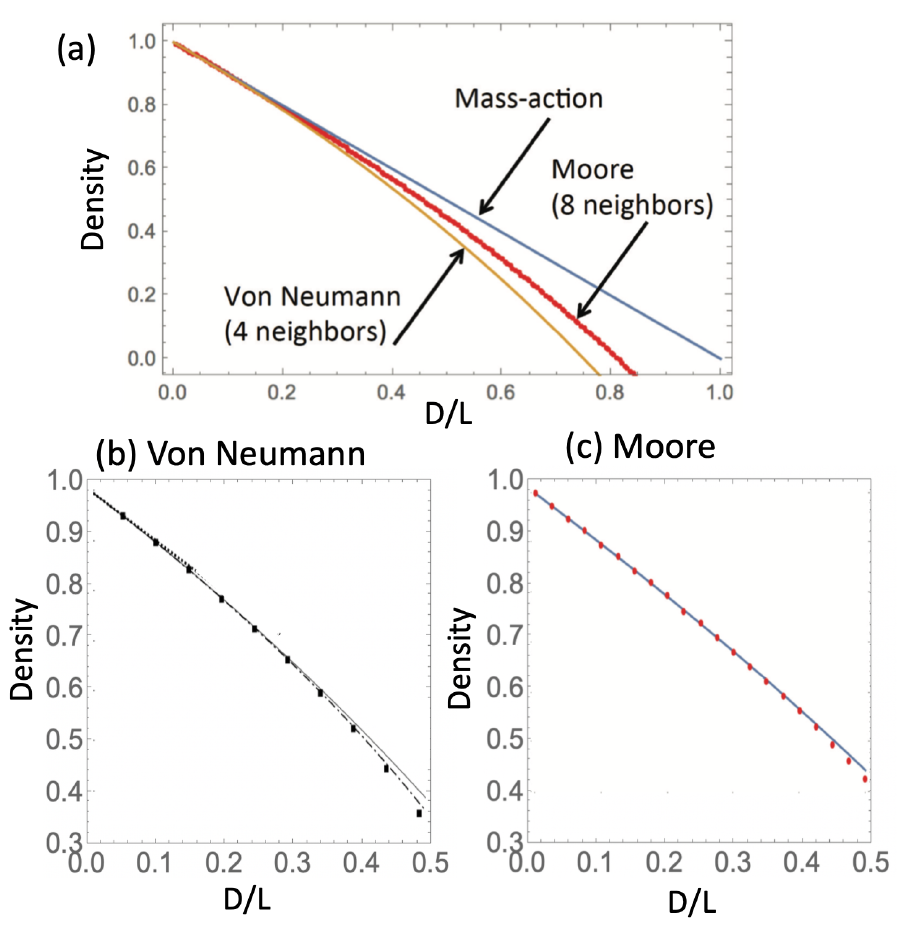
Figure 1. Quasi-equilibrium density of cells. ( a ) Equation (2), showing the equilibrium density as a function of D / L for N b = 4 (von Neumann lattice), N b = 8 (Moore lattice), and N b → ∞ (mass-action). ( b ) Comparison of Equation (2) (solid line) with numerically calculated density values (dots) for N b = 4. The dashed-dotted line represents a higher-order approximation; see [20] for details. ( c ) Comparison of Equation (2) (solid line) with numerically calculated density values (dots) for N b = 8. See text for